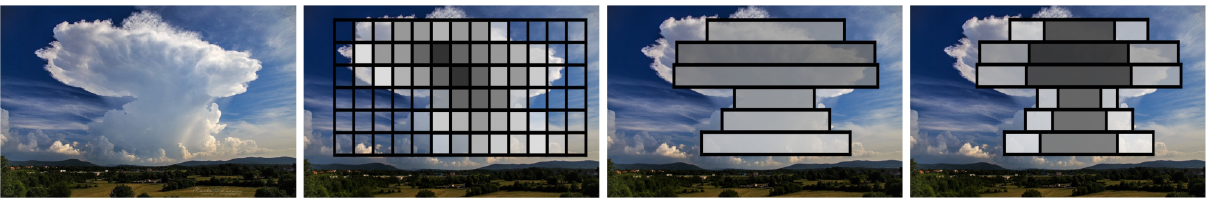
Figure 1. First panel: an explosive storm near Divaˇca, Slovenia (Marko Korošec Weather Photography; http://www.markokorosec.net, last access: 12 April 2021). Second panel: a representation of such storm in a cloud-resolving model (lighter/darker gray shading denotes smaller/larger optical thickness). Third panel: a traditional storm representation in coarse-resolution weather and climate models. Fourth panel: the Tripleclouds methodology. Note that the schematics are illustrative and that operational models employ finer vertical